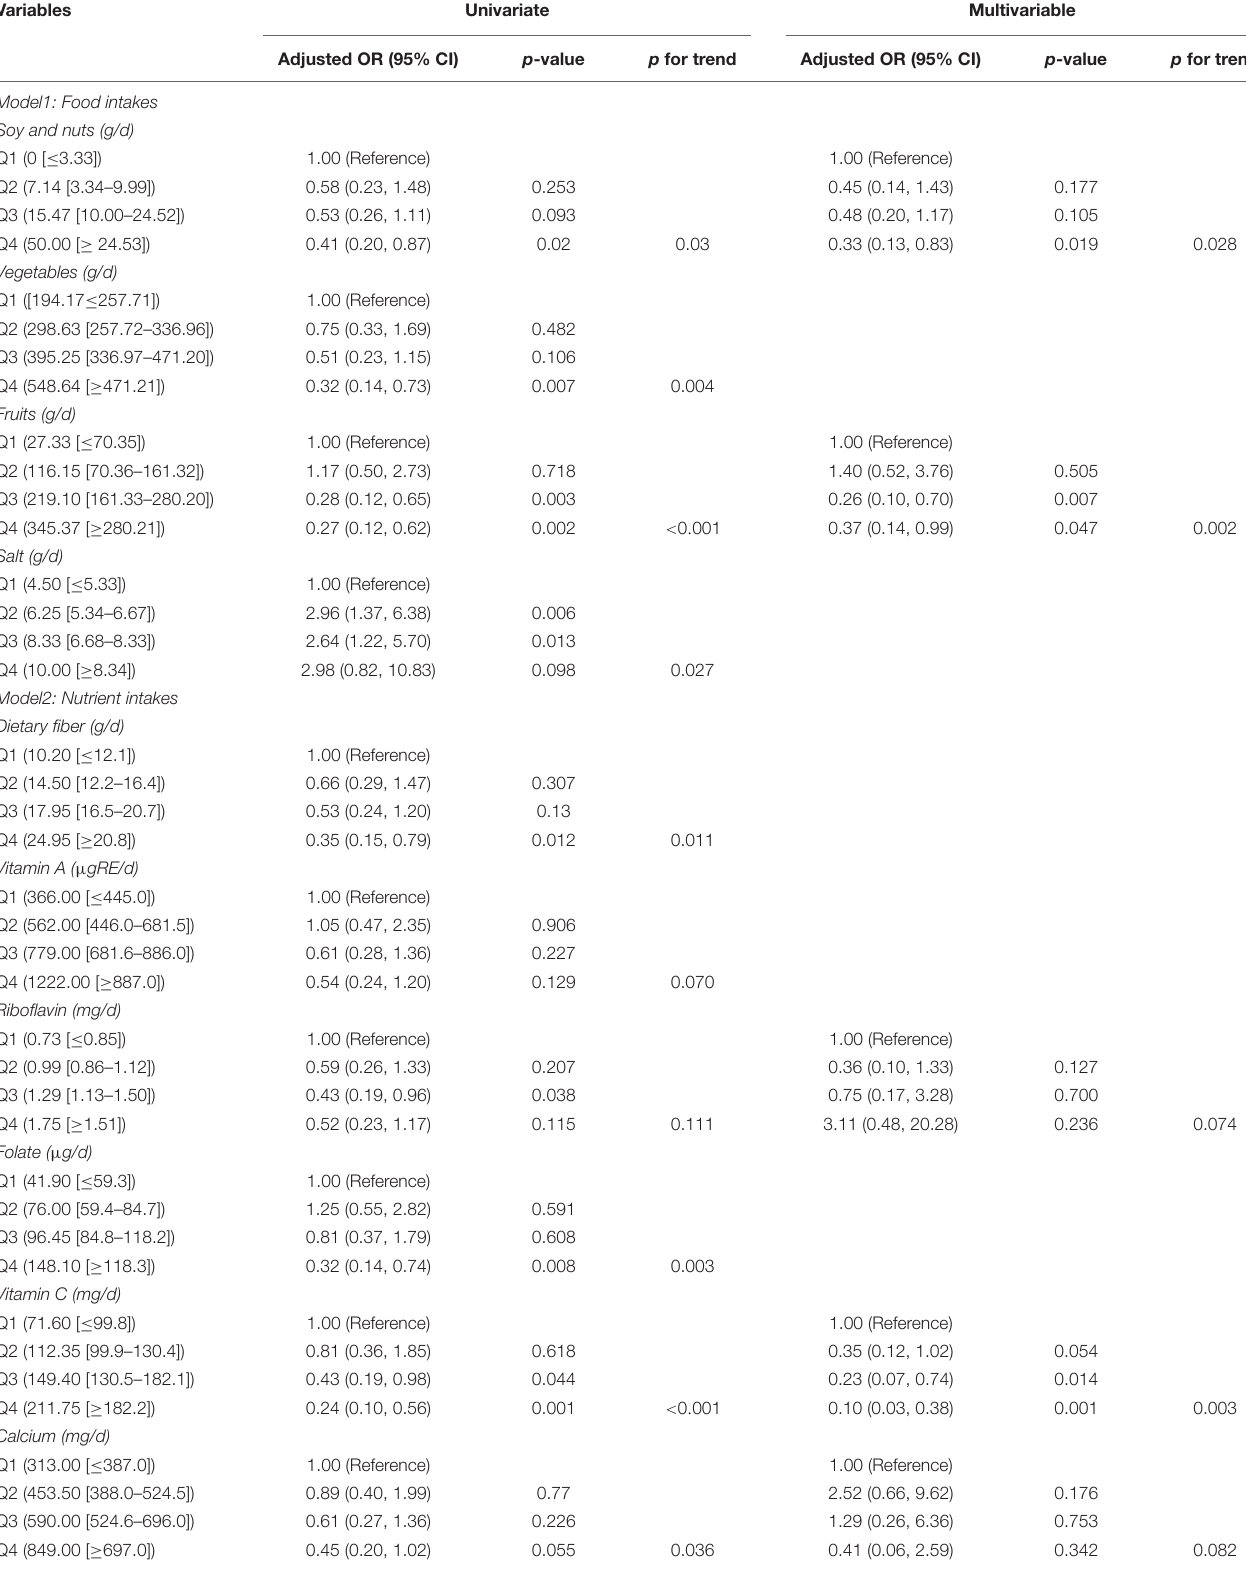
TABLE 4 | Logistic regression analysis on the associations between quartiles of food and nutrients and vulnerable plaque ( N = 194). Variables Univariate